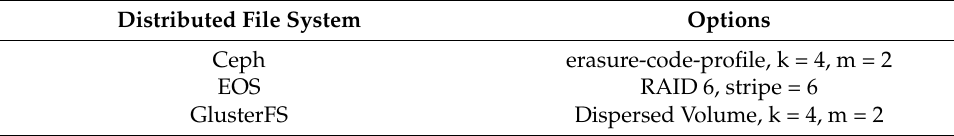
Table 6. RAID 6-like RAIN Layout.